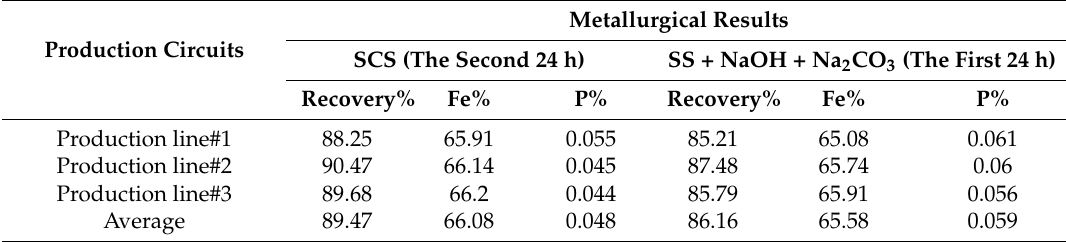
Table 5. Metallurgical results obtained from industrial experiments in the Chadormalu